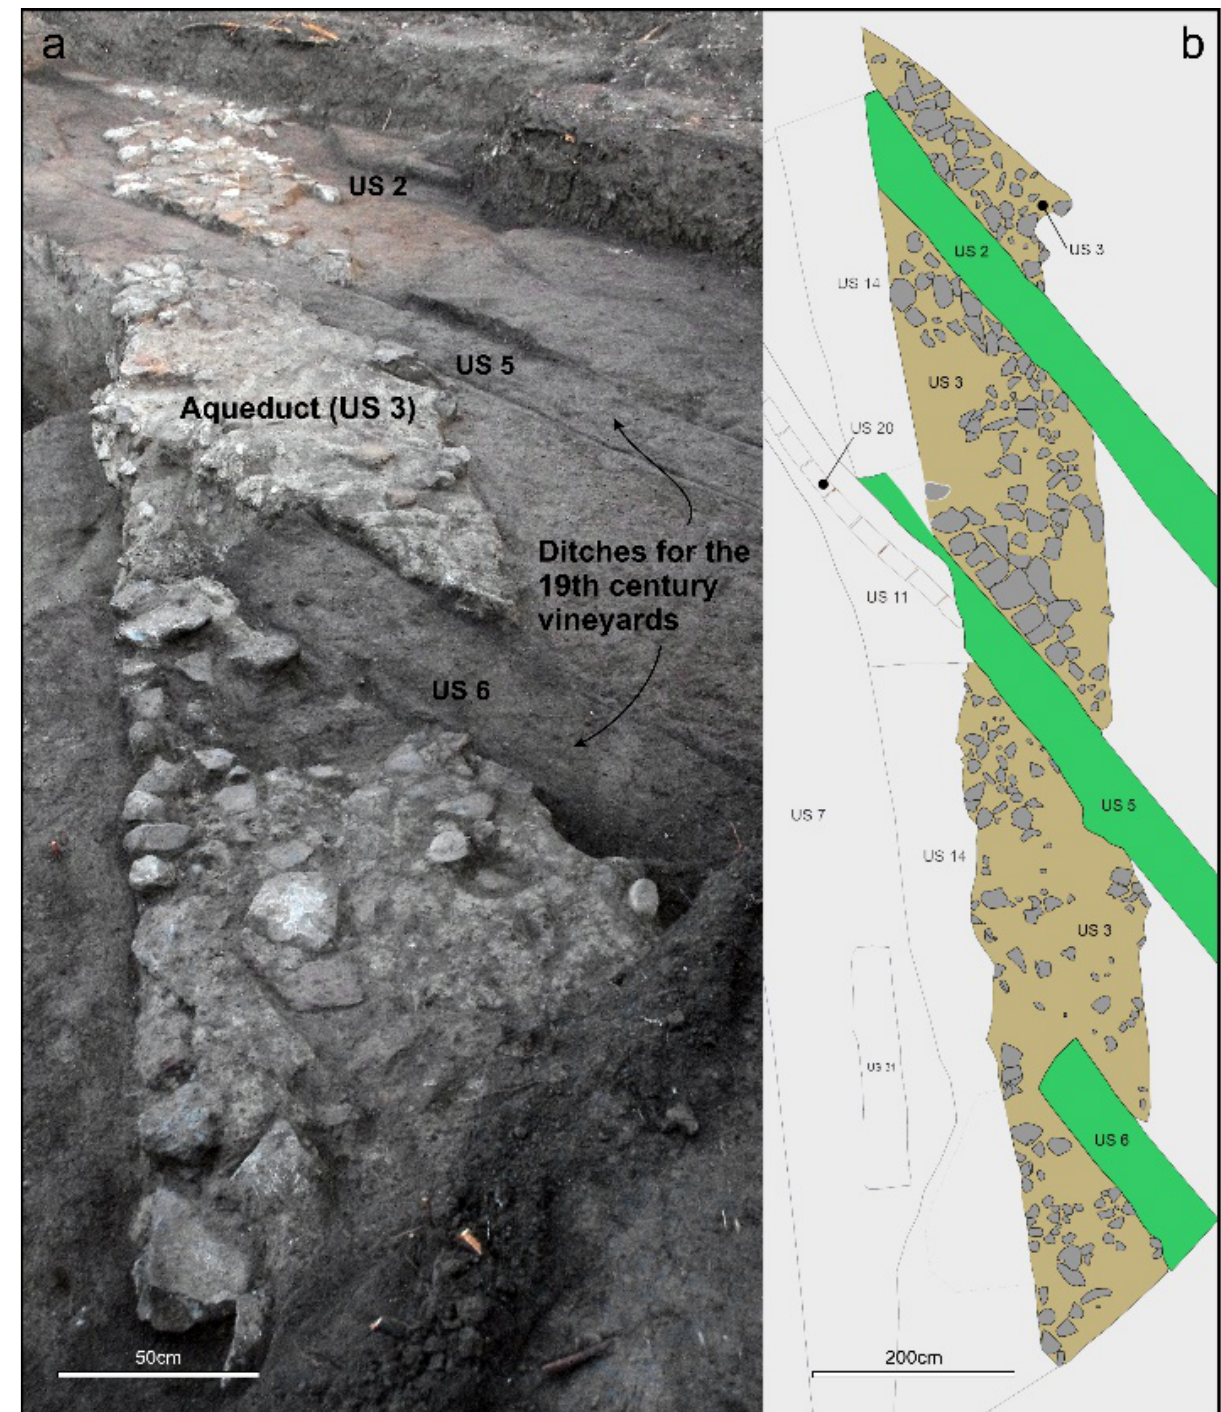
Figure 2 . Picture (a) and map (b) of the Sette Metri aqueduct. US, stratigraphic